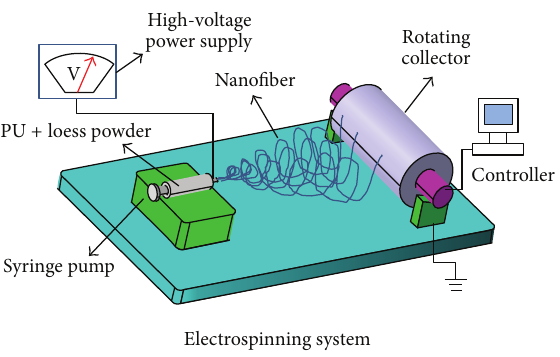
Figure 1: Schematic diagram of the electrospinning